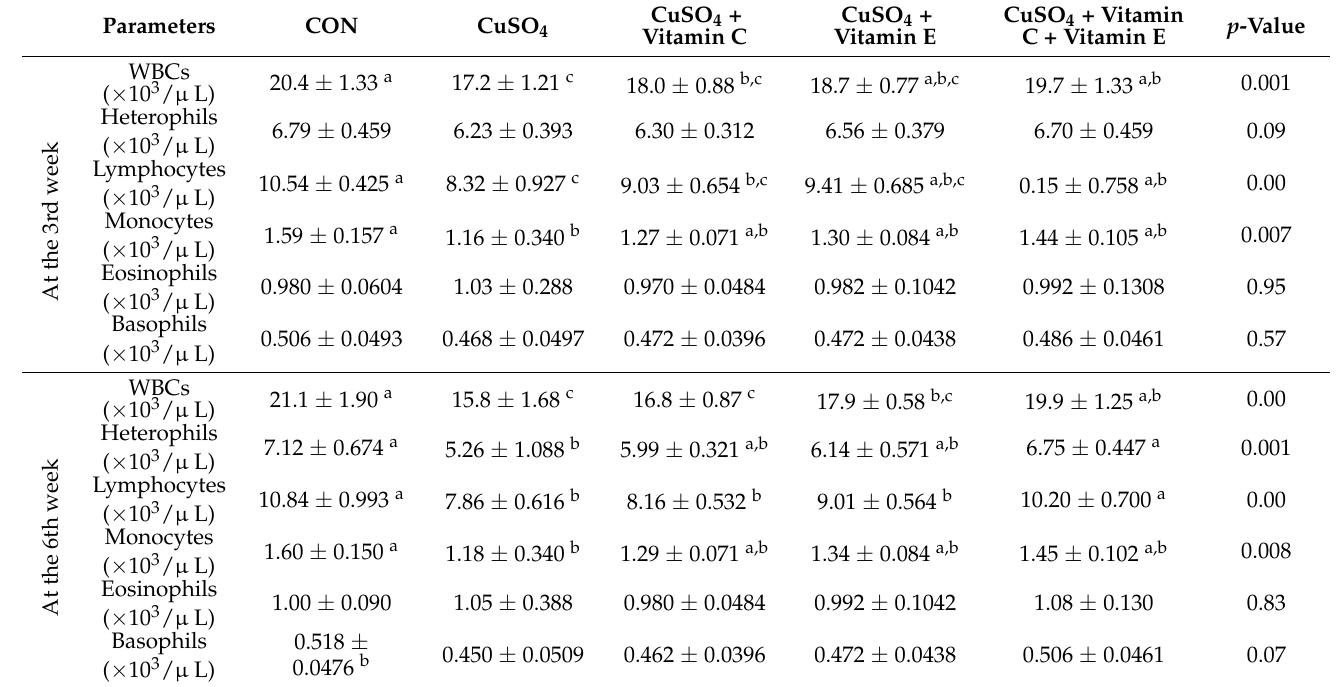
Table 3. Effect of single or combined supplementation of vitamin C and E on the leukogram of CuSO 4 -intoxicated broiler chickens (mean ± SD, n = 5).